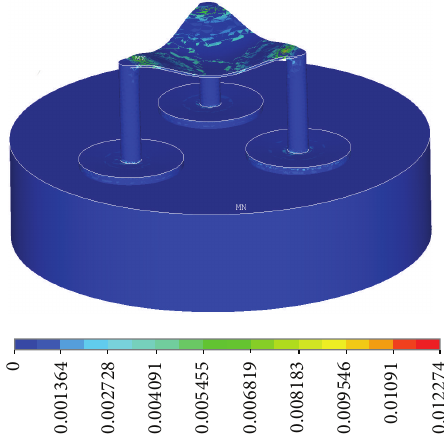
Figure 12: Strain intensity (Nodal Solution).